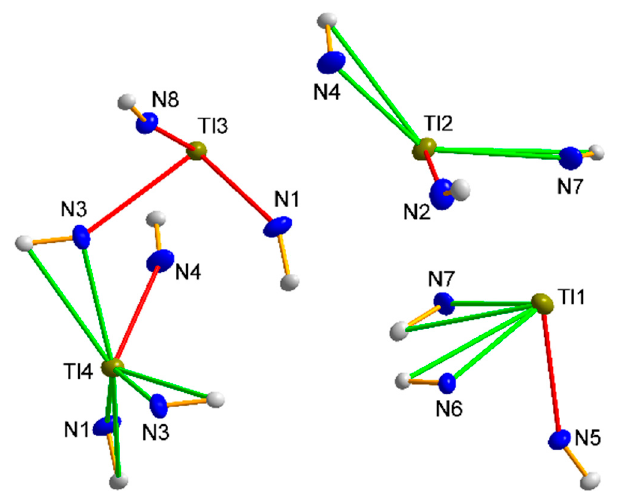
Figure 9. The asymmetric part of the cell unit of the compound 4 ( left ) and 5 ( right ) with the adopted numbering scheme. All atoms are represented at 30% probability thermal ellipsoids.